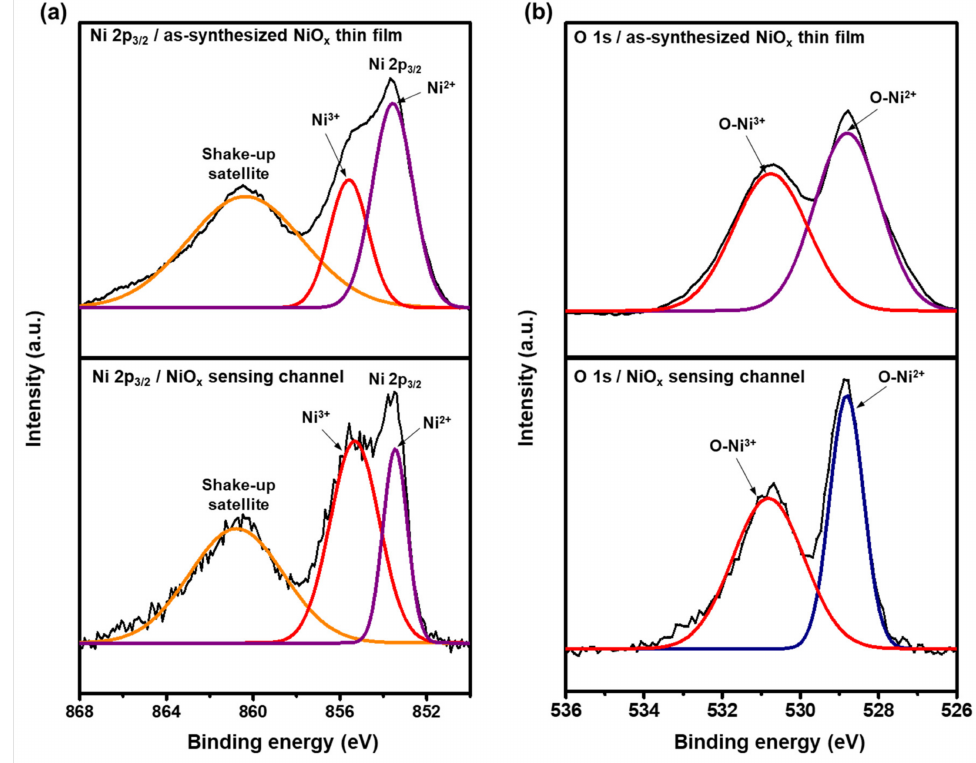
Figure 3. X-ray photoelectron spectroscopy (XPS) results from the as-synthesized NiO x thin film and the NiO x -sensing channel of the breath sensor for ( a ) Ni 2p 3/2 and ( b ) O